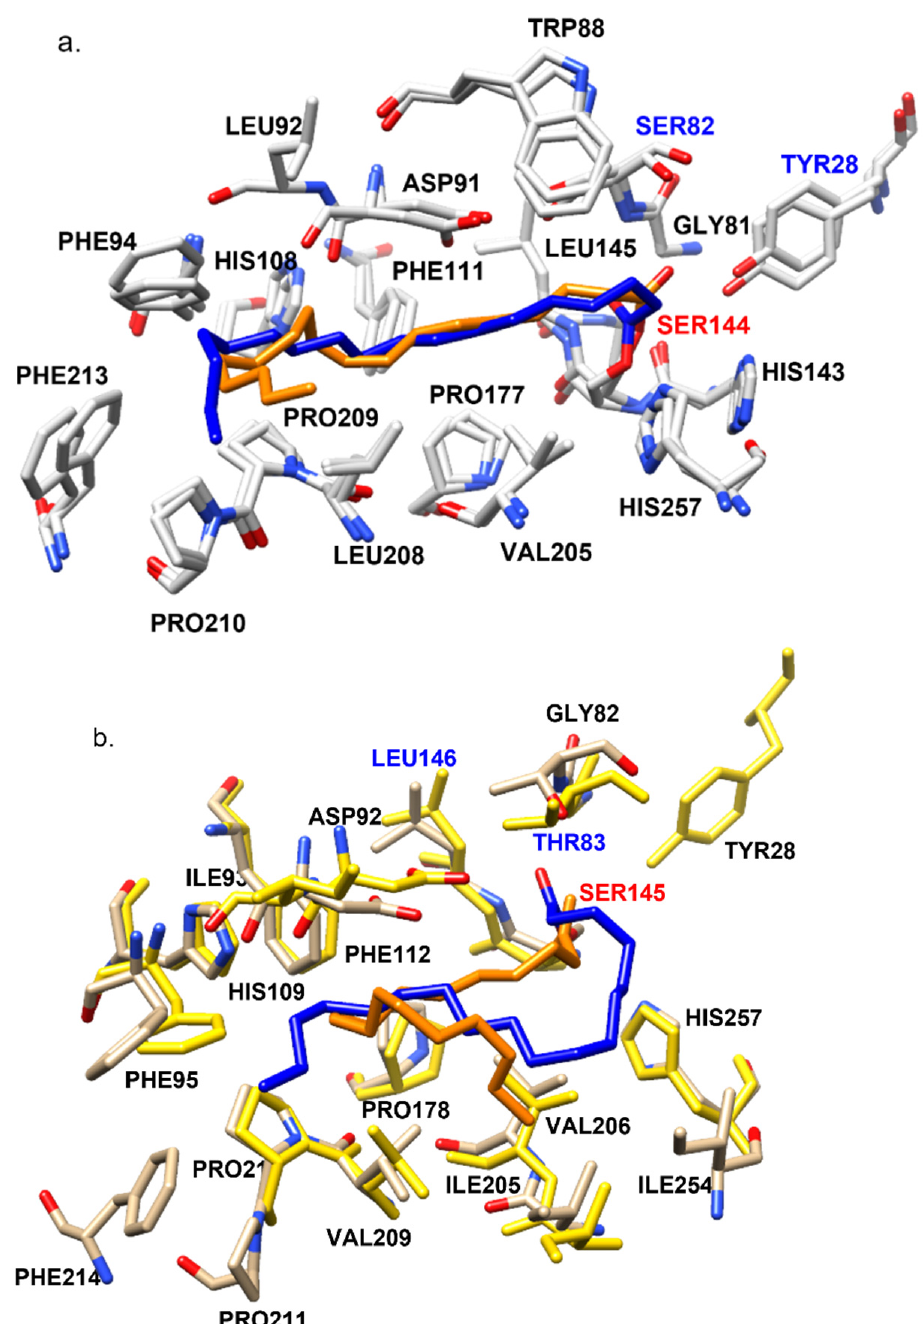
Figure 5. Docking complexes comparison with superposition. ( a ). Superimposing RMOL (amino acid residues marked in dark grey and the oleic acid ligand marked in orange) and RMST (amino